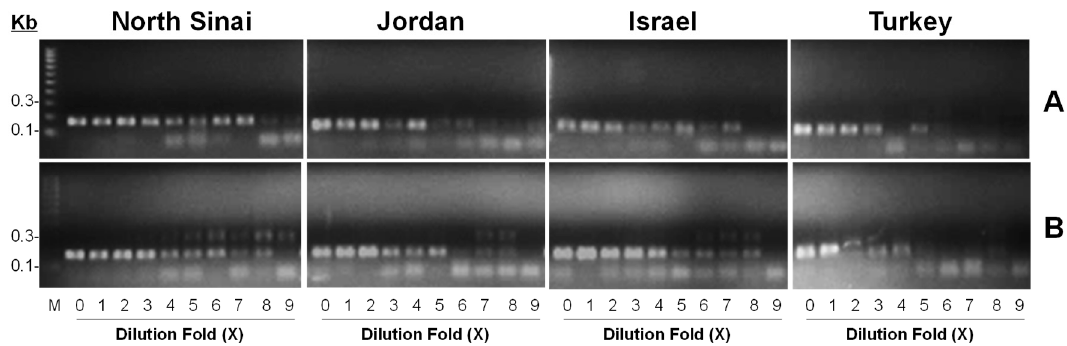
Figure 4. Validation of sensitivity. Field-collected P. papatasi samples from Israel, Jordan, North Sinai and Turkey were, respectively, subjected to a serial dilution with ddH 2 0 ( A ) or artificially mixed sand fly DNA samples ( B ) including L. shannoni , L. vexator and L. longipalpis . Dilution factor based on serial dilution comprised 0 (0), 1 (1), 2 (2), 3 (4), 4 (8), 5 (16), 6 (32), 7 (64), 8 (128) and 9 (256).